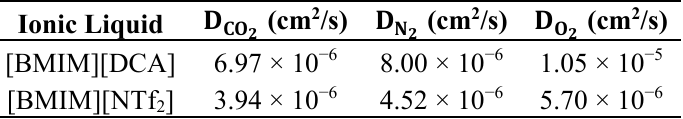
Table 4. Diffusivity coefficients for CO 2 , O 2 and N 2 in [BMIM][DCA] and [BMIM][NTf 2 ], calculated using Equation (1).